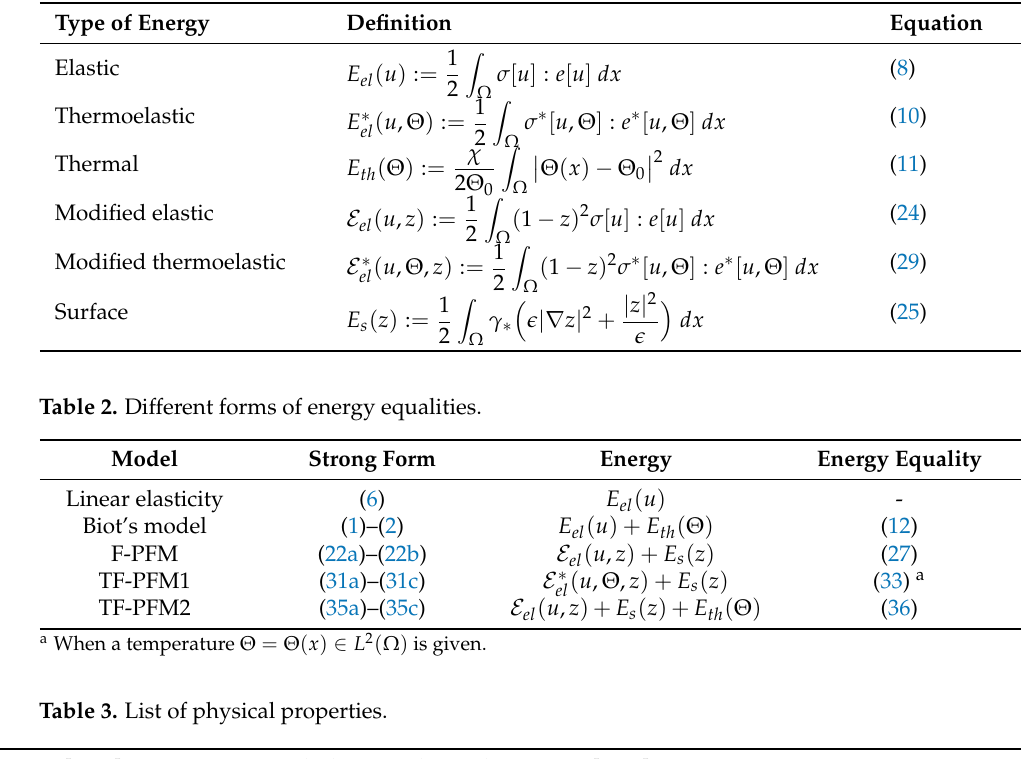
Table 1. List of energies.